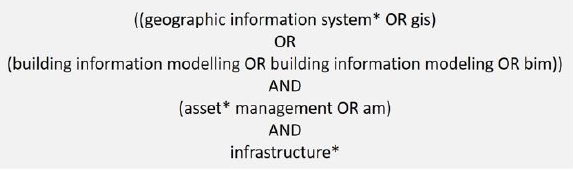
Figure 1. Search terms used in Scopus (“Article title, Abstract, Keywords” field) and in WoS (“Topic” field).